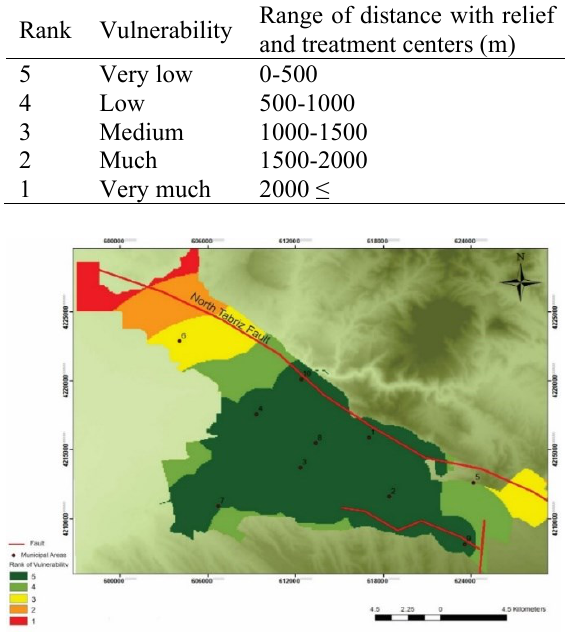
Fig. 6. Vulnerability map of Tabriz city based on distance from relief and treatment centers